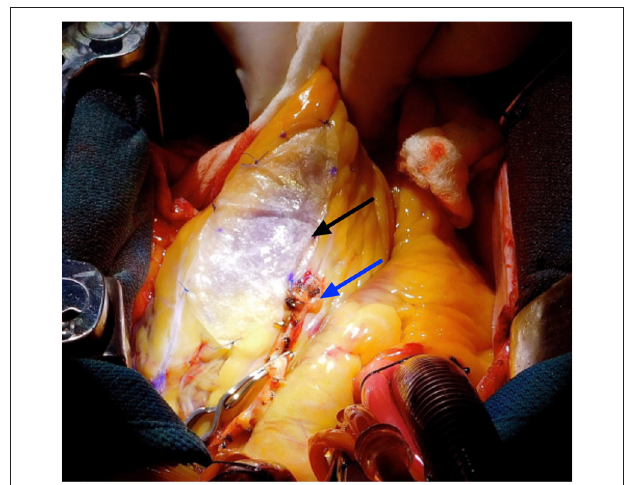
figURe 3 | Representative image of surgical implantation of a bioactive scaffold at the time of revascularization surgery. Patients were selected for bioactive scaffold therapy in adjunct with CABG and followed by serial cardiac MRI up to six months following surgery. Black arrow indicates acellular bioactive scaffold. Blue arrow indicates bypass